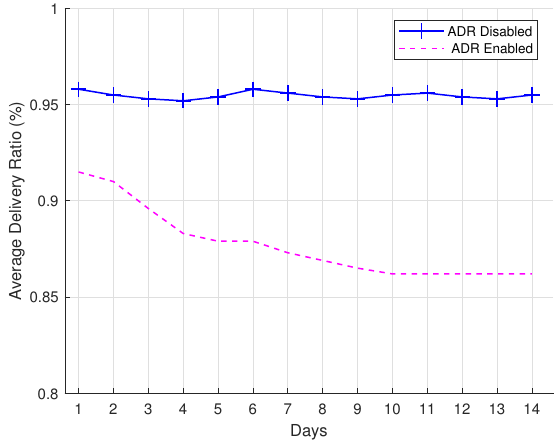
Figure 8. Convergence